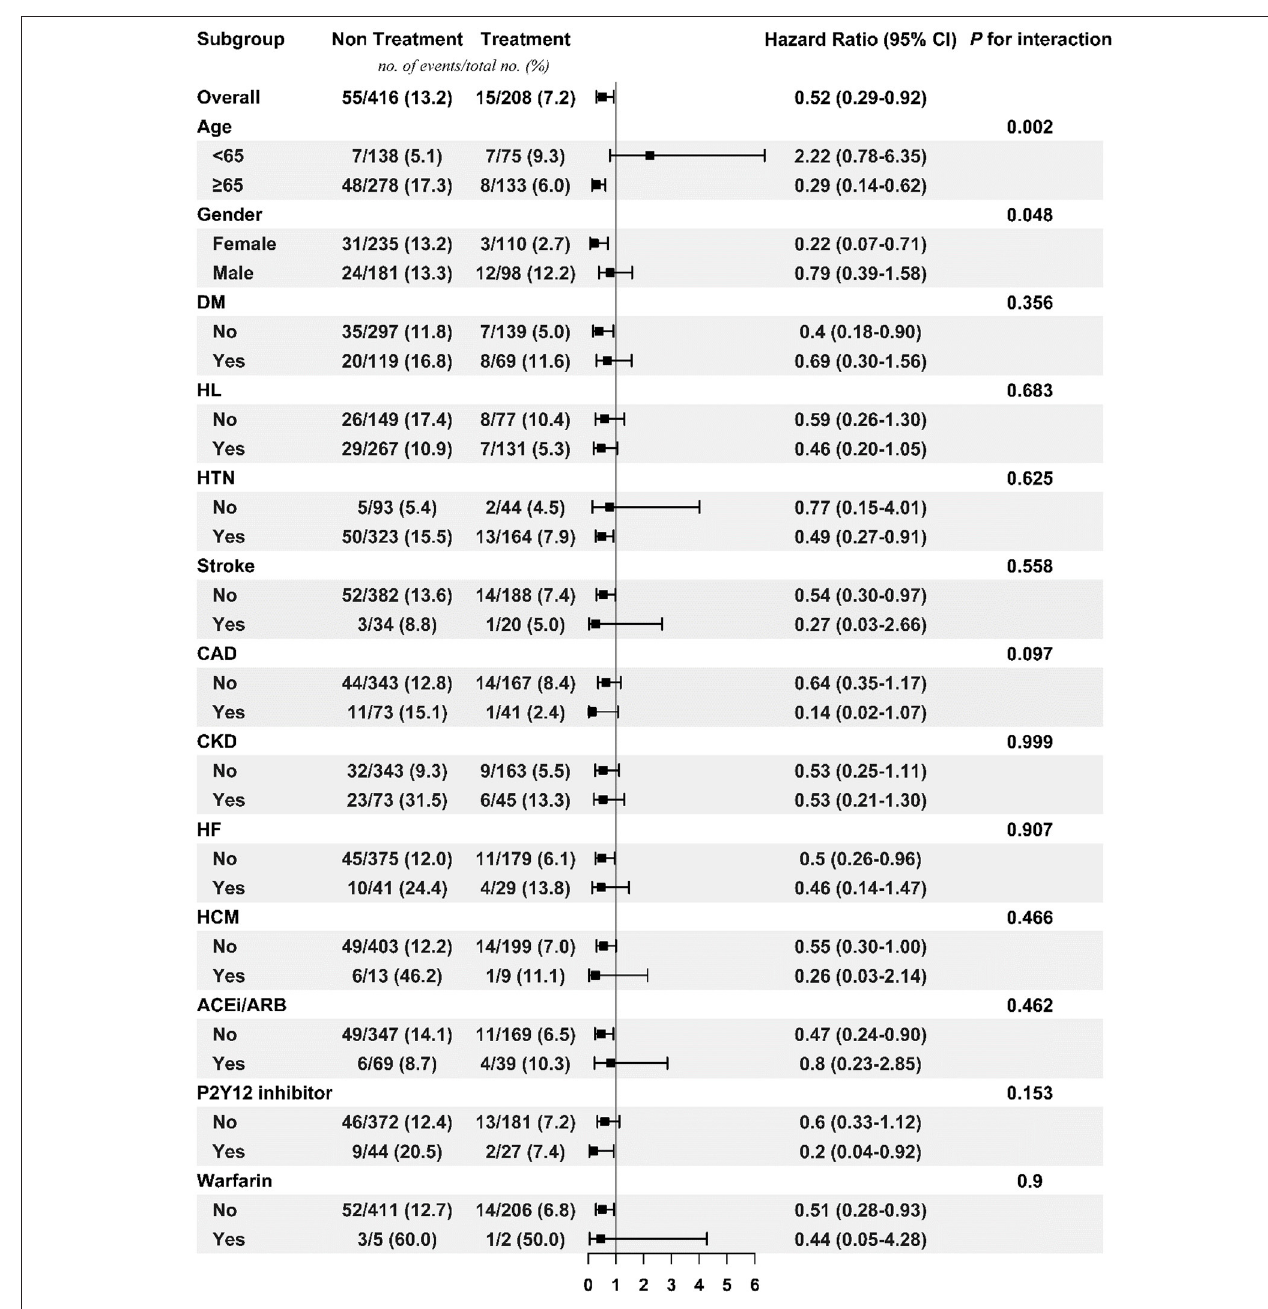
FIGURE 3 | Subgroup analysis of treatment effect on mortality in the high PAC burden sub-cohort. ACEi/ARB, angiotensin-converting enzyme inhibitor/angiotensin receptor blocker; CAD, coronary artery disease; CKD, chronic kidney disease; DM, diabetes mellitus; HCM, hypertrophic cardiomyopathy; HF, heart failure; HL, hyperlipidemia; HTN, hypertension; PAC, premature atrial